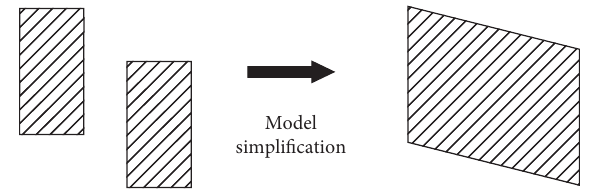
Figure 1: Schematic diagram of model simplification (plan view).